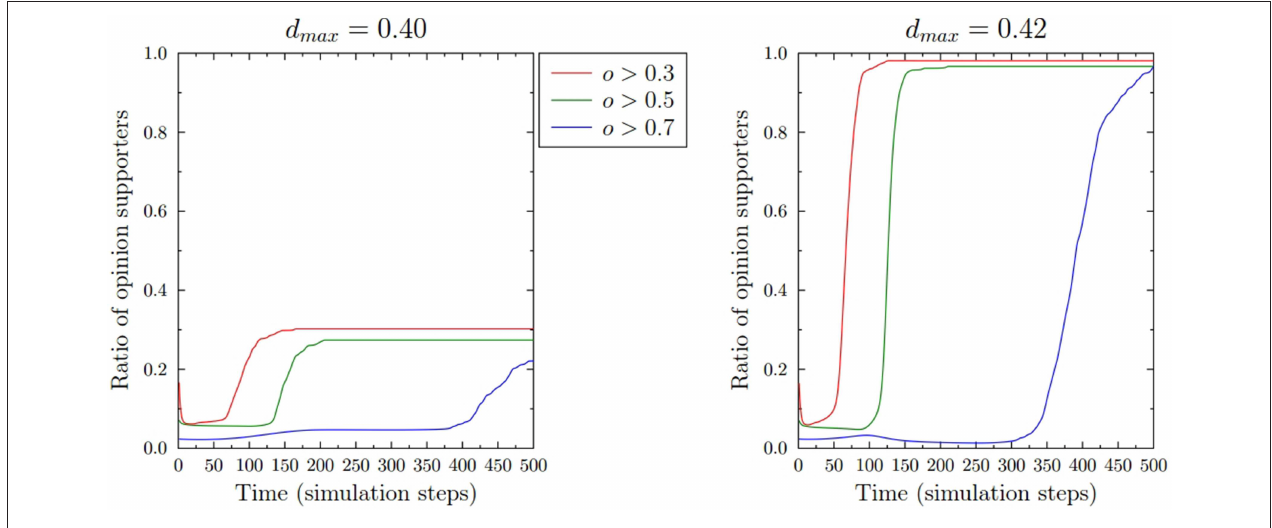
FIGURE 9 | Time dependence of the ratio of agents with opinions greater than 0.3, 0.5, and 0.7, respectively, in the case of L = 2 and exponential initial conditions. If one defines the general support for the issue as having an opinion greater than 0.3 and the extreme views as those